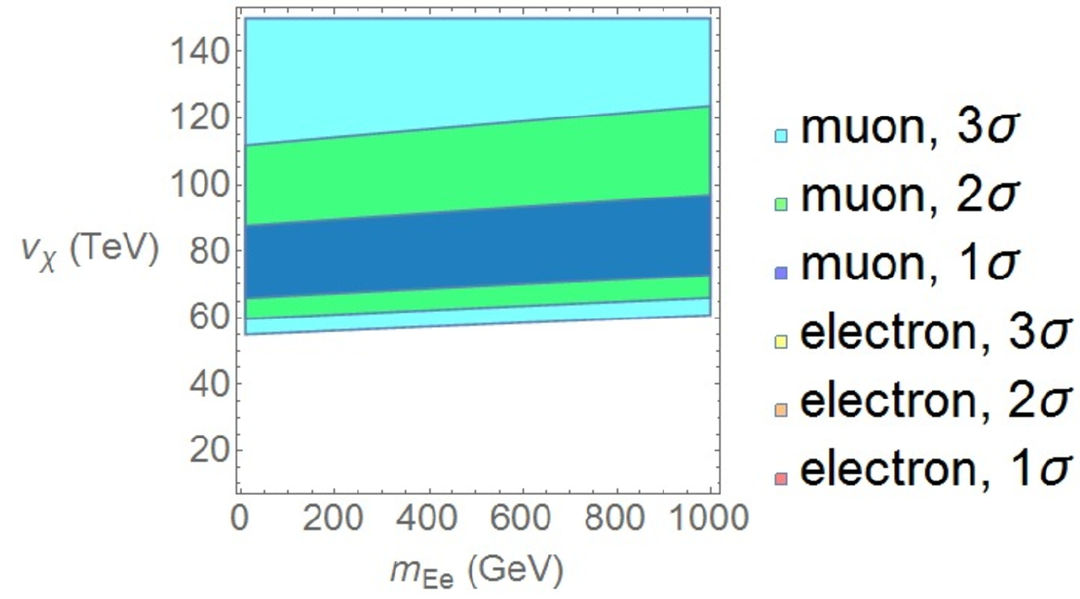
= m E = 500, m = 1000, Y + 1 (cid:22) (cid:28)